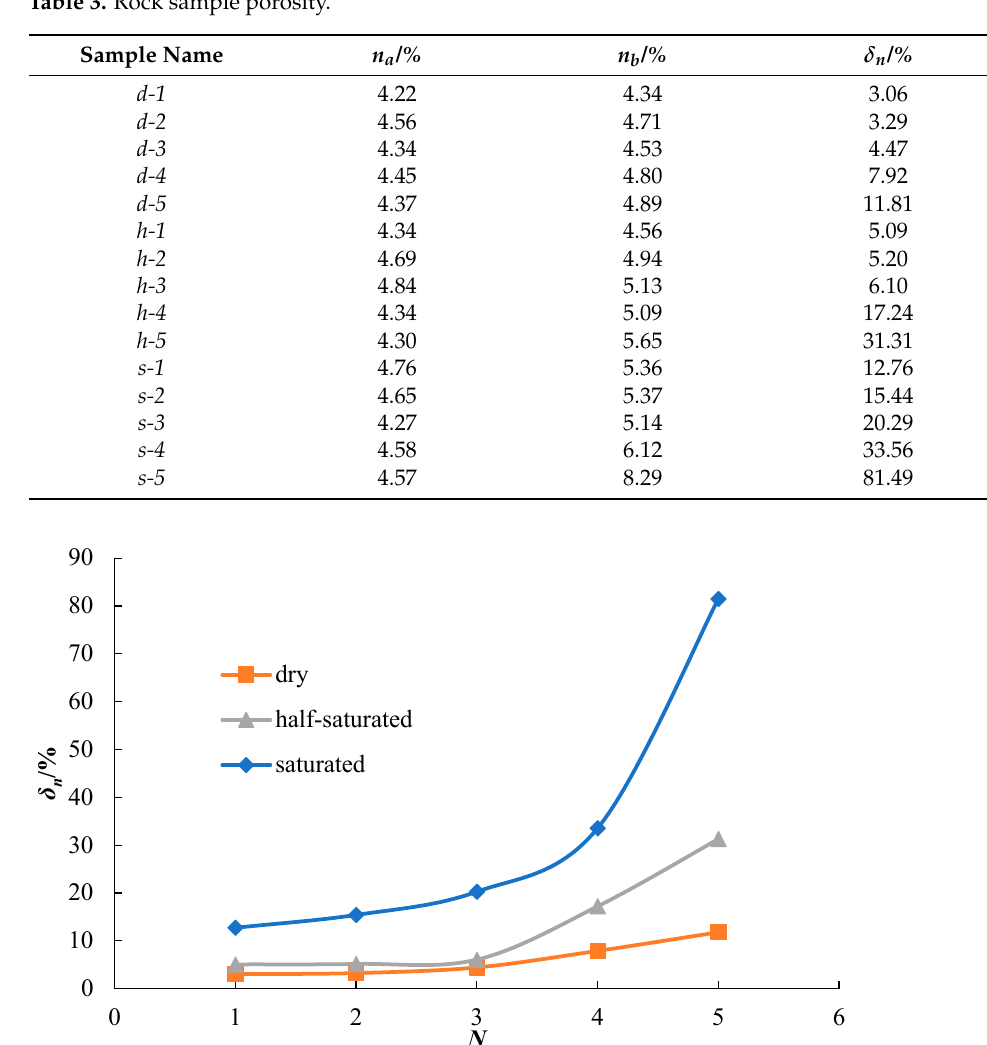
Table 3. Rock sample porosity.